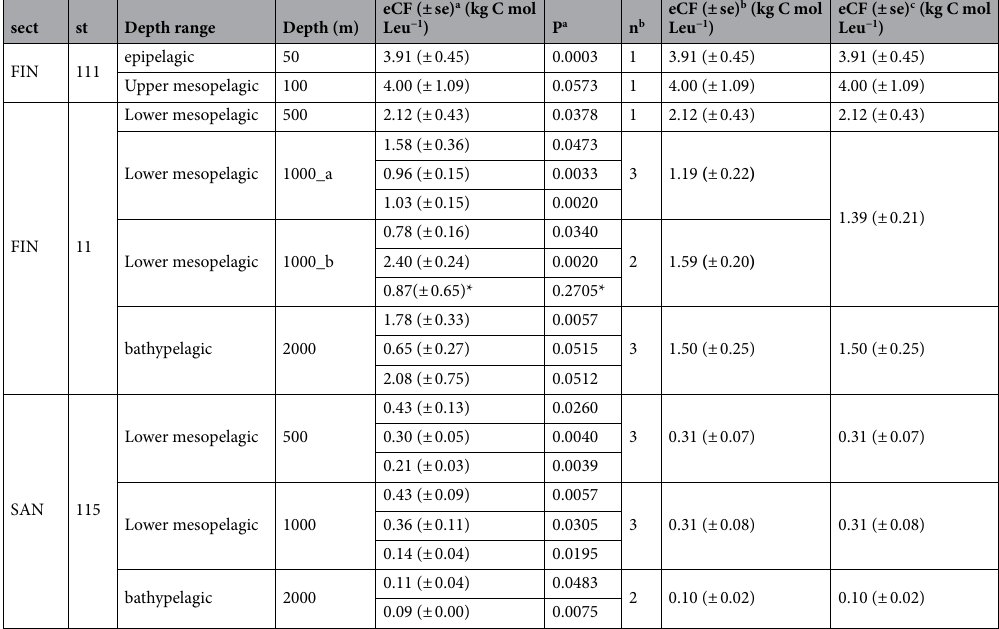
Table 2. Empirical carbon conversion factors (eCFs, kg C mol Leu −1 ) determined in stations 111, 11 and 115 of Finisterre (FIN) and Santander (SAN) sections, respectively. Significant values are in bold. a Values of eCF and P value per experiment curve. Significant experiments ( P value threshold, P < 0.1) were considered for calculating mean eCF values per sample. b Number of experiments and mean eCF values per sample. c Final eCF values per depth. *This experiment curve was not used in this study as the regression was not significant.